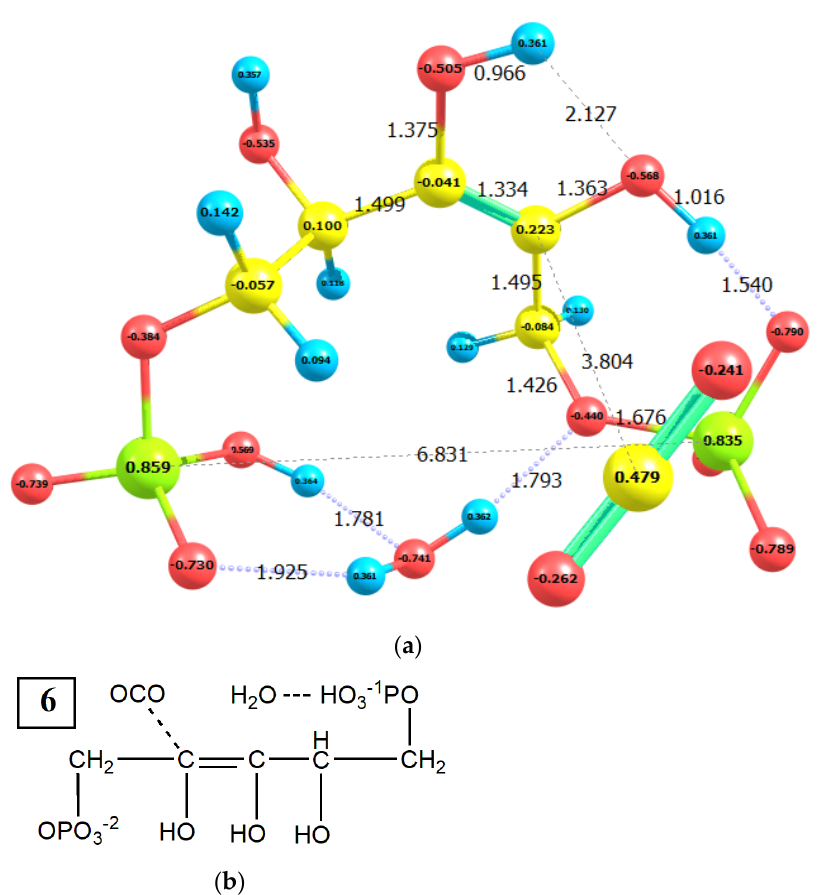
tive frequencies. ( b ) The scheme of state (6 ′ ) is pictured in Figure 5b.